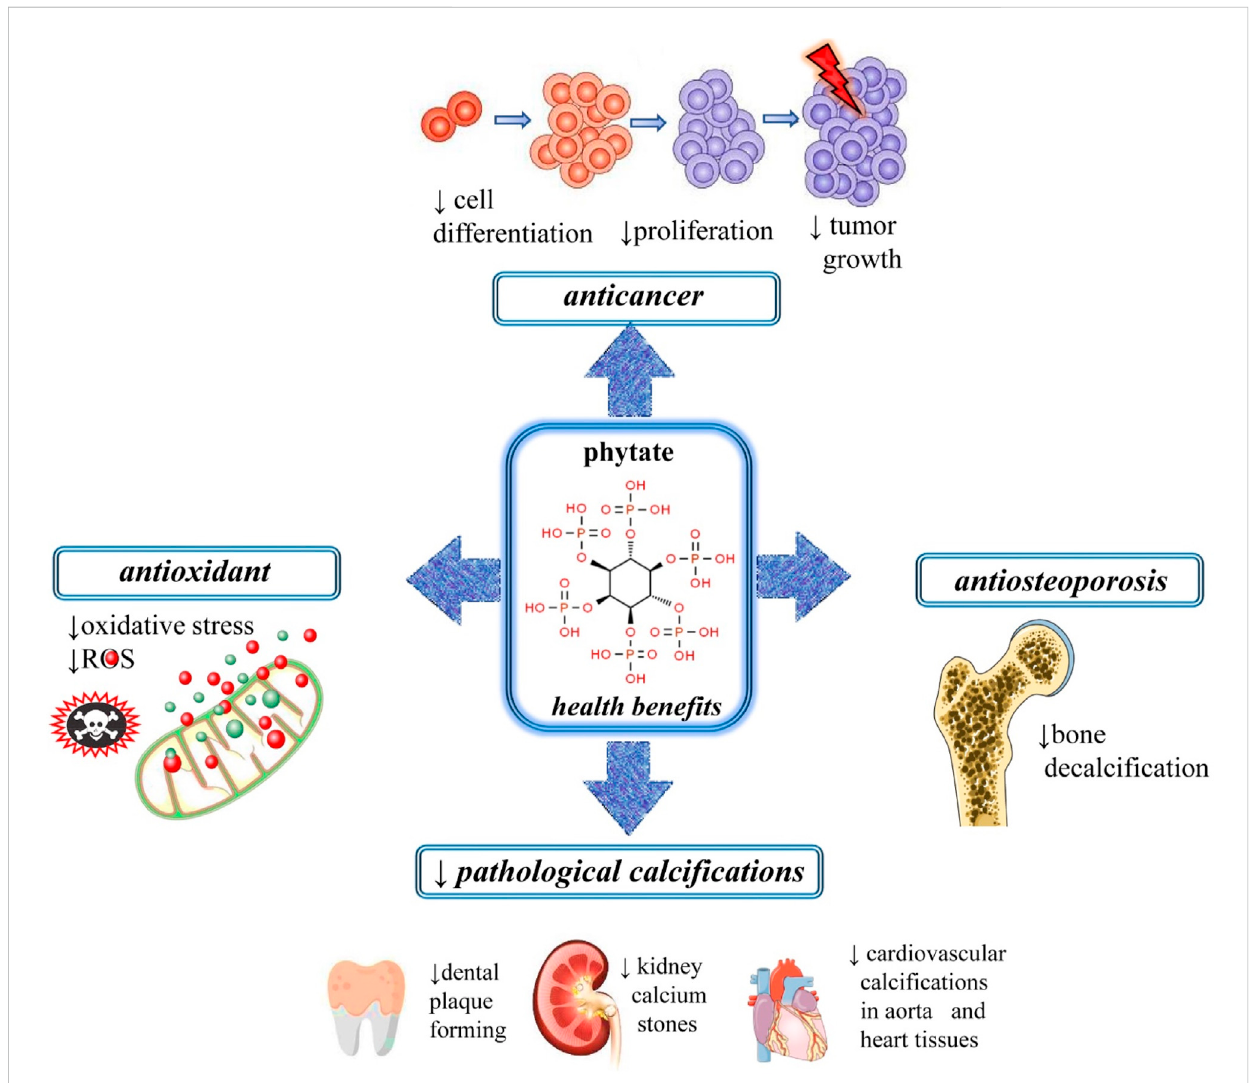
FIGURE 4 Illustrative fi gure with the most important therapeutic applications of phytates. Abbreviations and symbols: ↑ increase, ↓ decrease, ROS, reactive oxygen